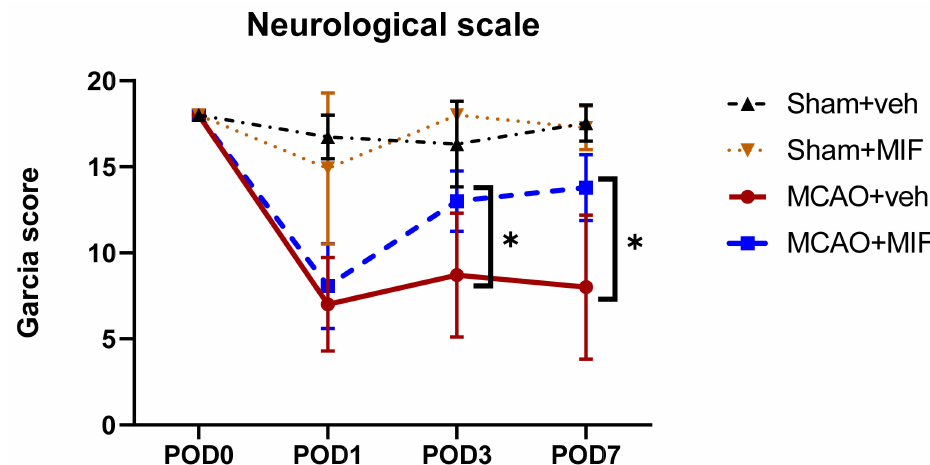
Figure 1. Results of the Garcia score in the MCAO+veh ( n = 14), MCAO+MIF ( n = 14), Sham+veh ( n = 15), and Sham+MIF ( n = 15) groups. At POD 1 after MCA occlusion surgery, the neurological scale of the MCAO groups decreased. At POD 3 and 7, the neurological scale of the MCAO+MIF group had recovered and was higher compared to that of the MCAO+veh group (* p < 0.0001). The Mean ± SD values are presented here. The data were analyzed using one-way ANOVA, and post-analysis was performed using Tukey’s post hoc test. MCAO: middle cerebral artery occlusion; MIF: macrophage migration inhibitory factor.